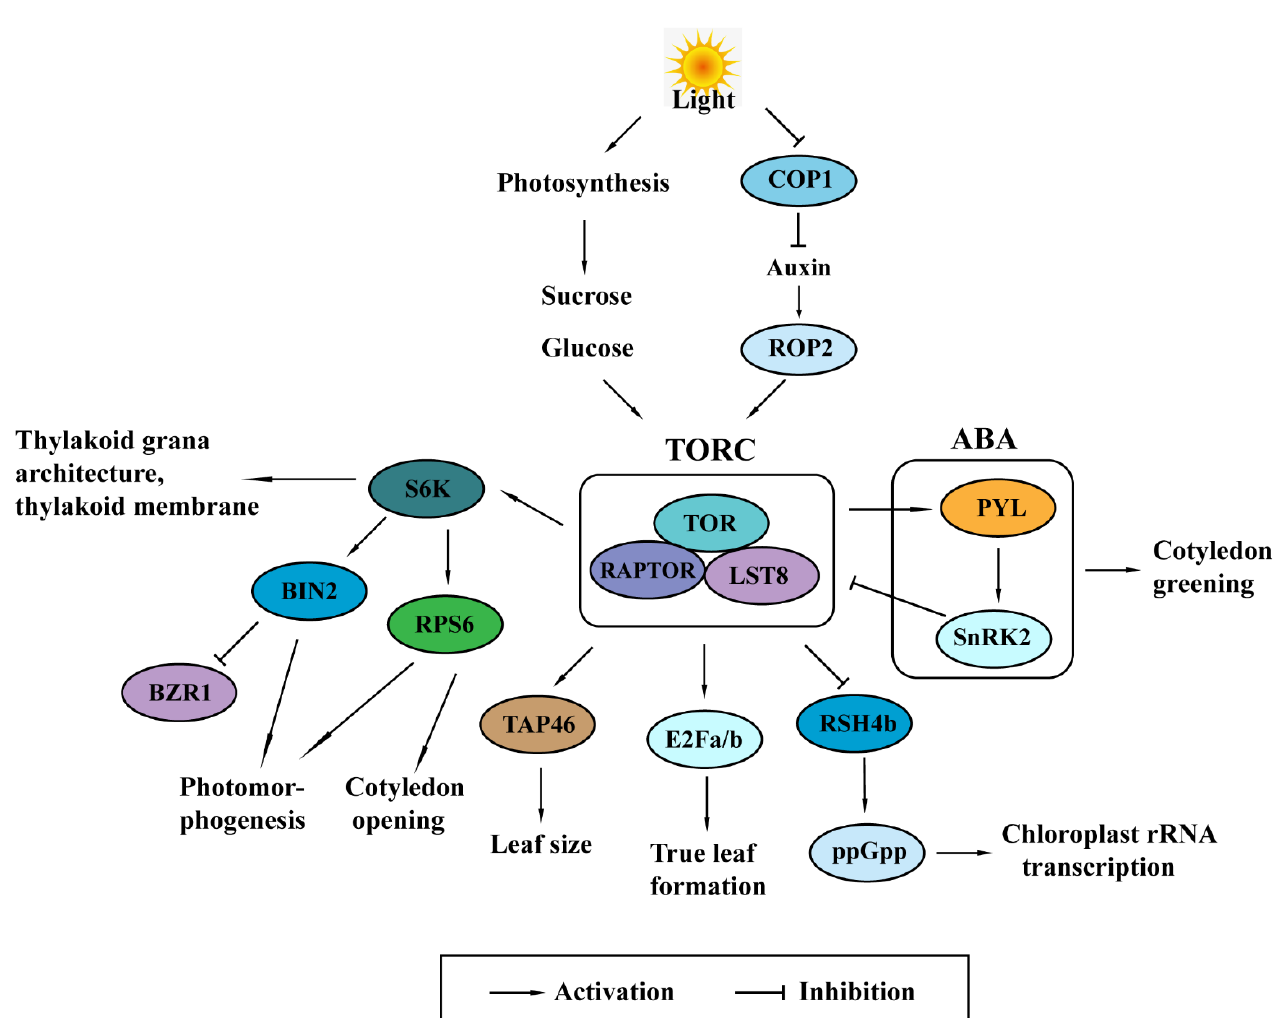
Figure 2. Summary of Target of Rapamycin (TOR) signaling in plant photosynthesis, including inputs for the activation of TOR signaling and output processes regulated by the TOR signaling. Light signals and sugars derived from photosynthesis activate TOR signaling and the conserved downstream outputs. The activated TOR downstream outputs regulate photomorphogenesis and leaf development, which eventually influences the efficiency of oxygenic photosynthesis. Abbreviations: COP1, constitutive photomorphogenesis 1; ROP2, Rho-like small GTPase 2; TORC, Target of Rapamycin complex; TOR, Target of Rapamycin; RAPTOR, regulatory-associated protein of mTOR; LST8, lethal with Sec13 protein 8; S6K, S6 kinase; BIN2, brassinosteroid-insensitive 2; BZR1, brassinazole resistance 1; RPS6, ribosomal protein S6; TAP46, type